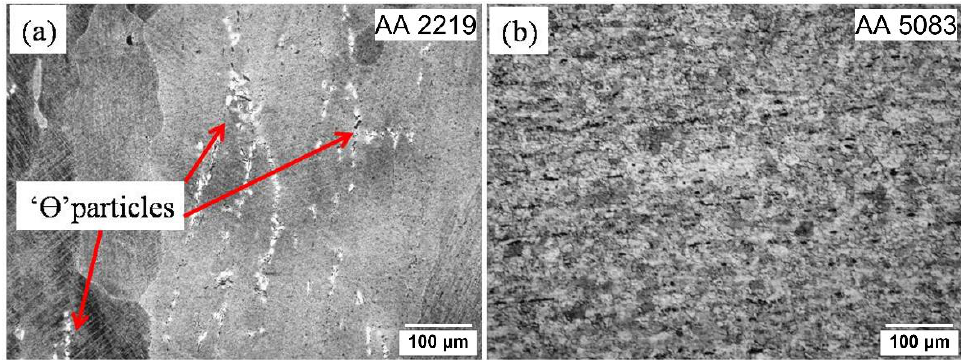
Figure 4. Typical optical micrographs of base materials. ( a ) AA 2219-T6; ( b ) AA 5083-H116.